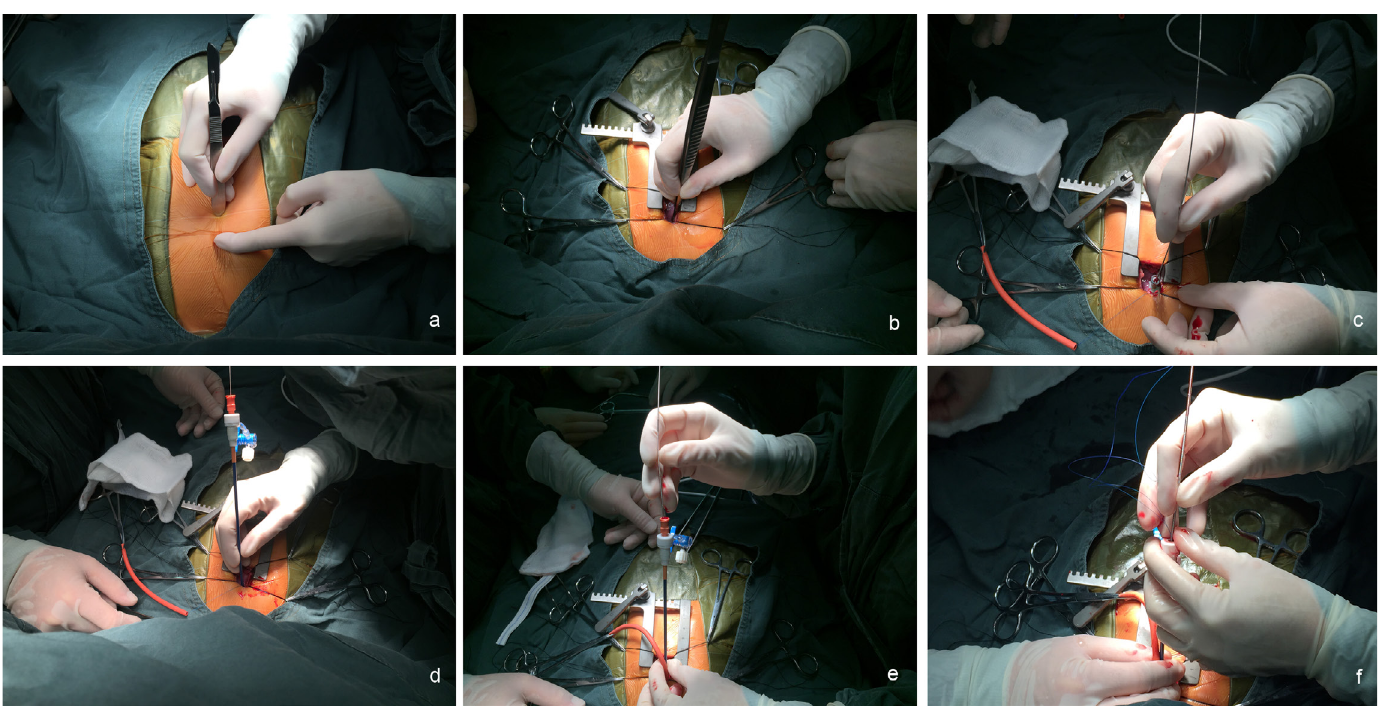
Fig. 1 - Images of the procedure. A: planning the incision site. B: selection of the puncture site in the right ventricle. C: an 18G venous indwelling needle was inserted through a purse-string suture, and a guidewire was advanced to the right ventricle. D: the needle was removed, and a delivery sheath was advanced over the guidewire. E: the device was advanced through the delivery sheath. F: the device was deployed after the device was in the correct position.